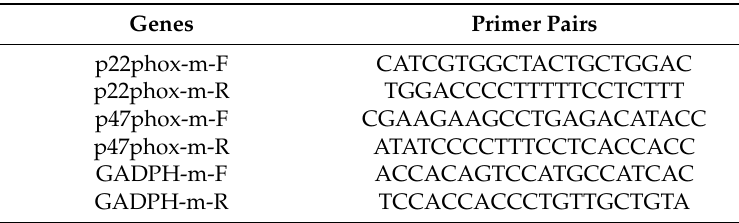
Table 1. Sequence of